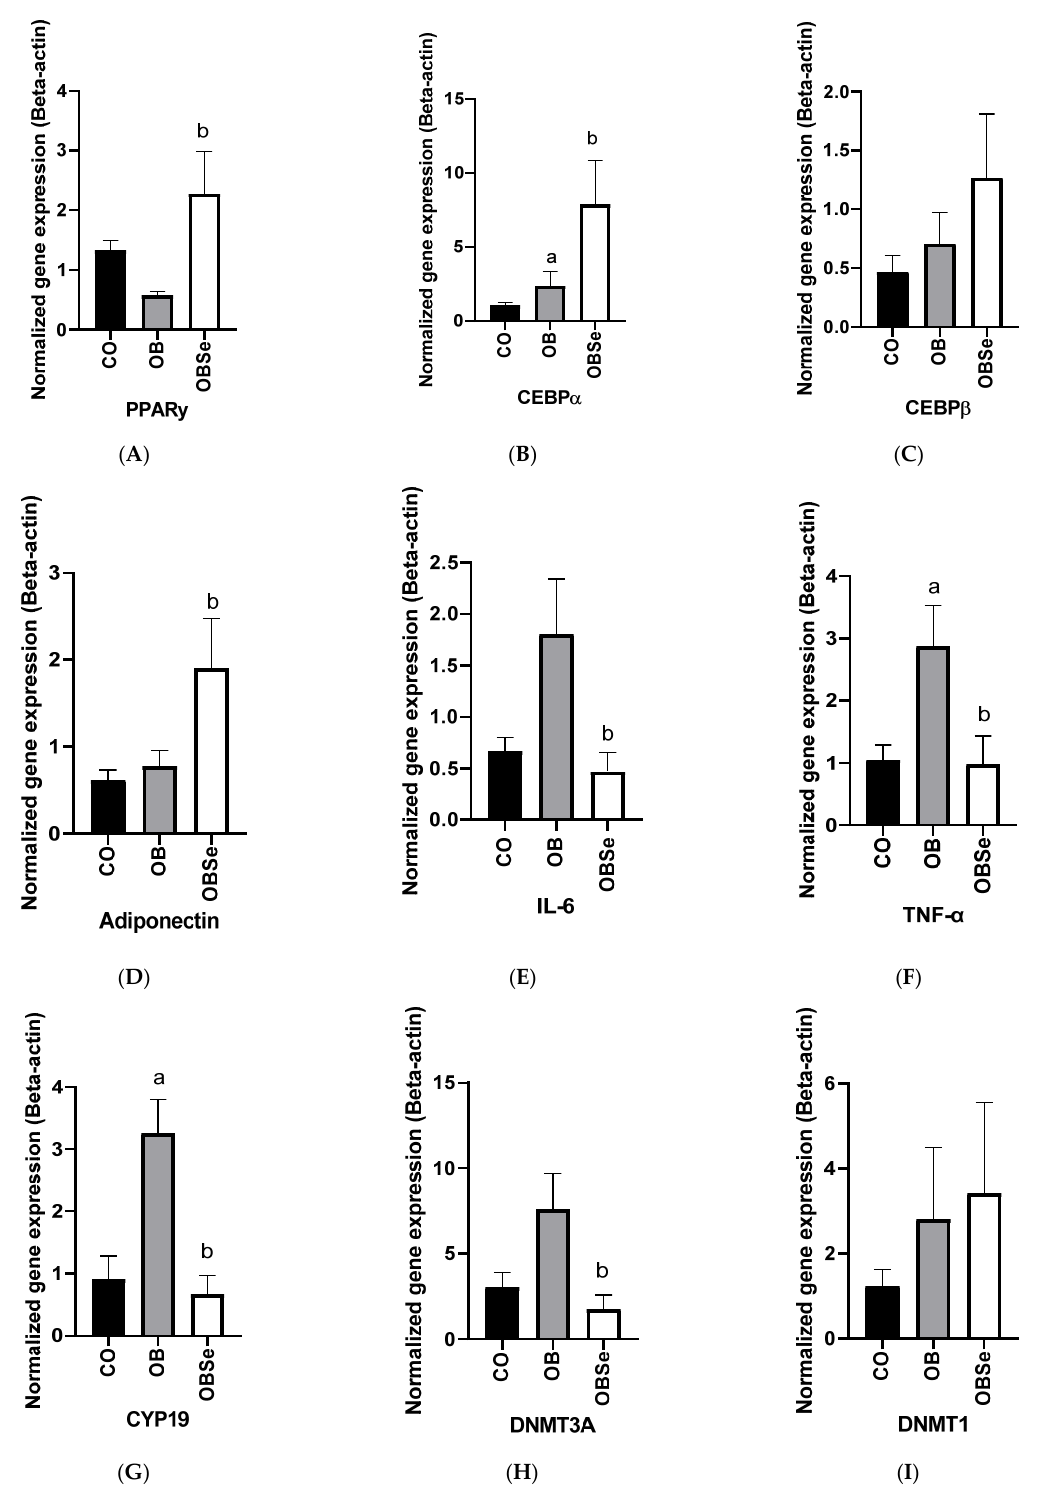
Figure 5. Effect of high-fat obesogenic diet and Se supplementation on gene expression in epididymal adipose tissue: ( A ) PPARy; ( B ) CEBP α ; ( C ) CEBP β ; ( D ) Adiponectin; ( E ) IL-6; ( F ) TNF α ; ( G ) CYP-19; ( H ) DNMT3A; ( I ) DNMT1. Data represent the mean ± SEM ( n = 5/group). Statistically significant difference ( p ≤ 0.05) compared to a CO and b OB groups according to one-way ANOVA, followed by Tukey’s multiple comparisons